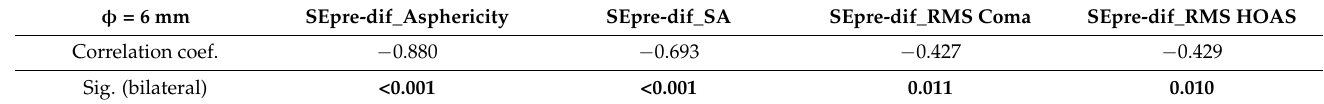
Table 3. Correlations of preoperative SE with the difference between pre- and post-surgery values ob- tained for asphericity, SA, RMS coma and RMS HOAS. Statistically significant values are highlighted in